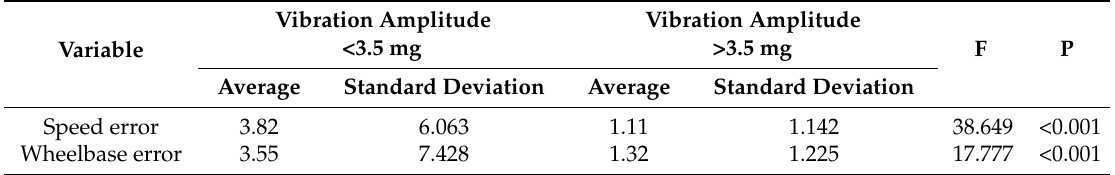
Table 4. Variance